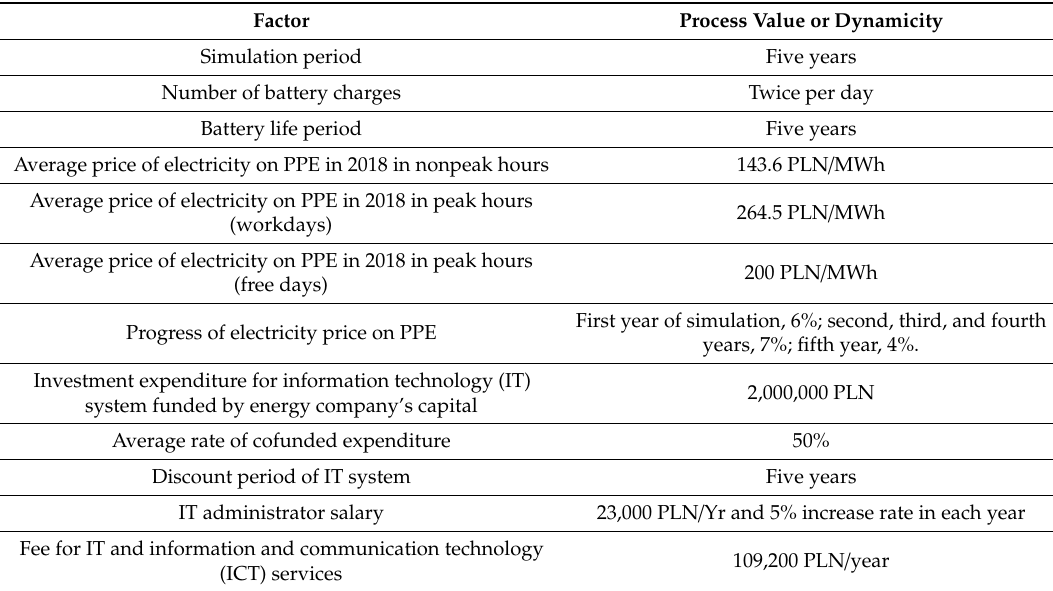
Table 2. Assumptions in each